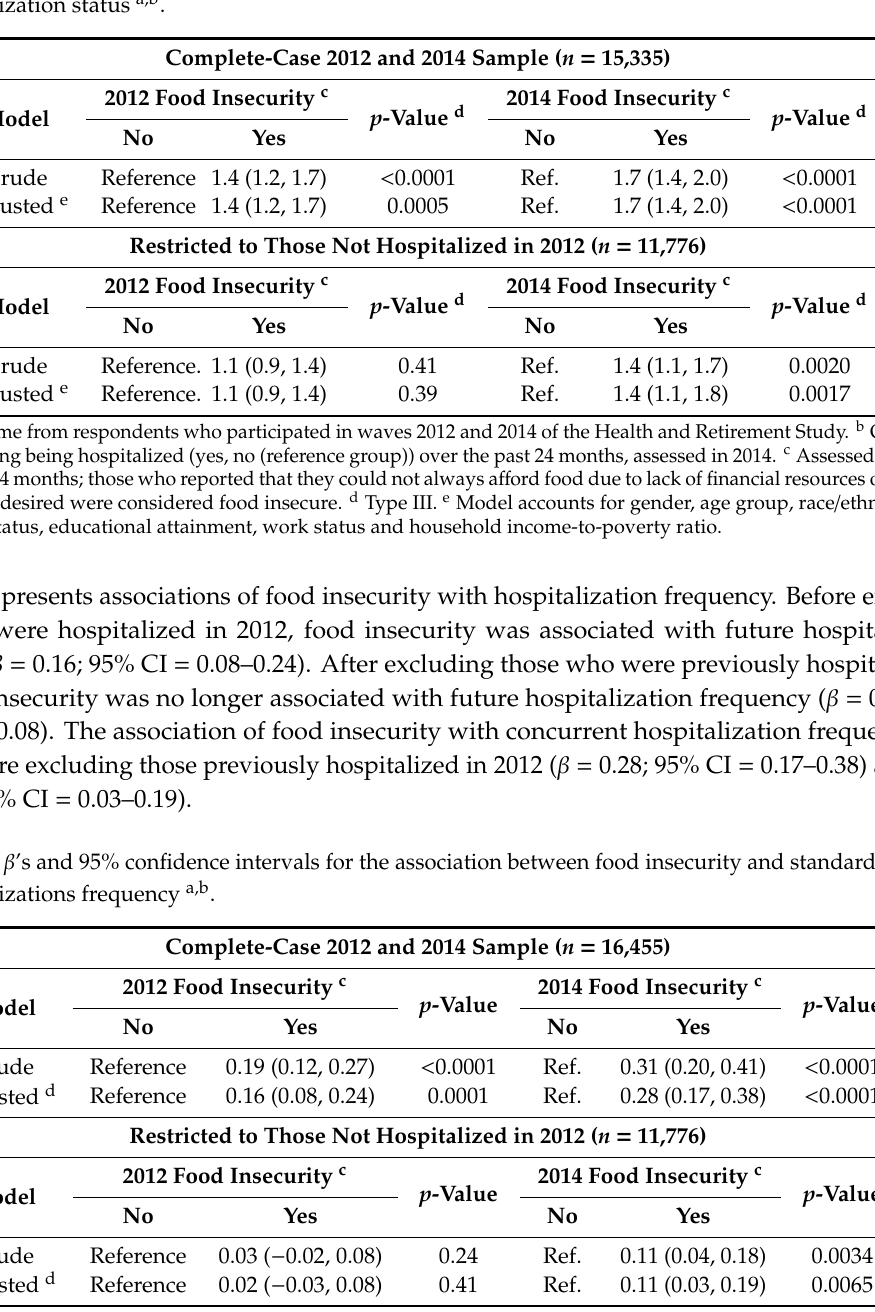
Table 2. Odds ratios and 95% confidence intervals for the association between food insecurity and hospitalization status a,b .